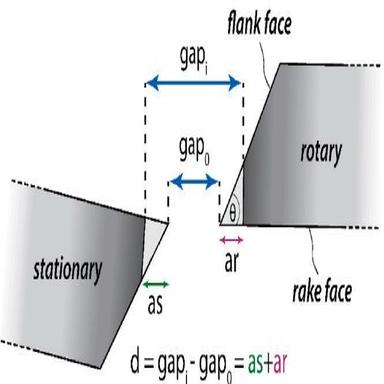
Schematic of a recessive gap measurement between a stationary and a rotary blade.